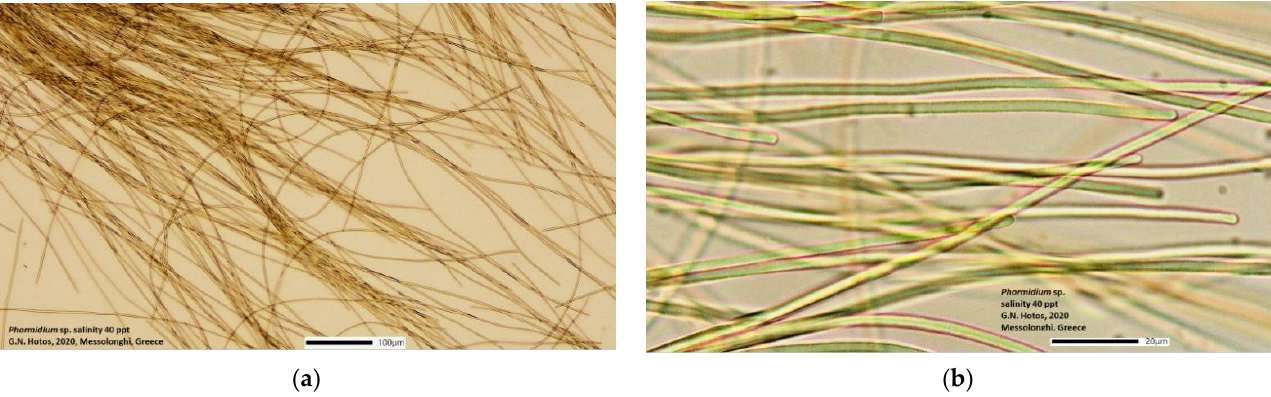
Figure 1. Filaments of Phormidium sp. from culture: ( a ) Mass of filaments at 100× magnification; ( b ) Closer look at 630× magnification of the filaments of Phormidium sp.